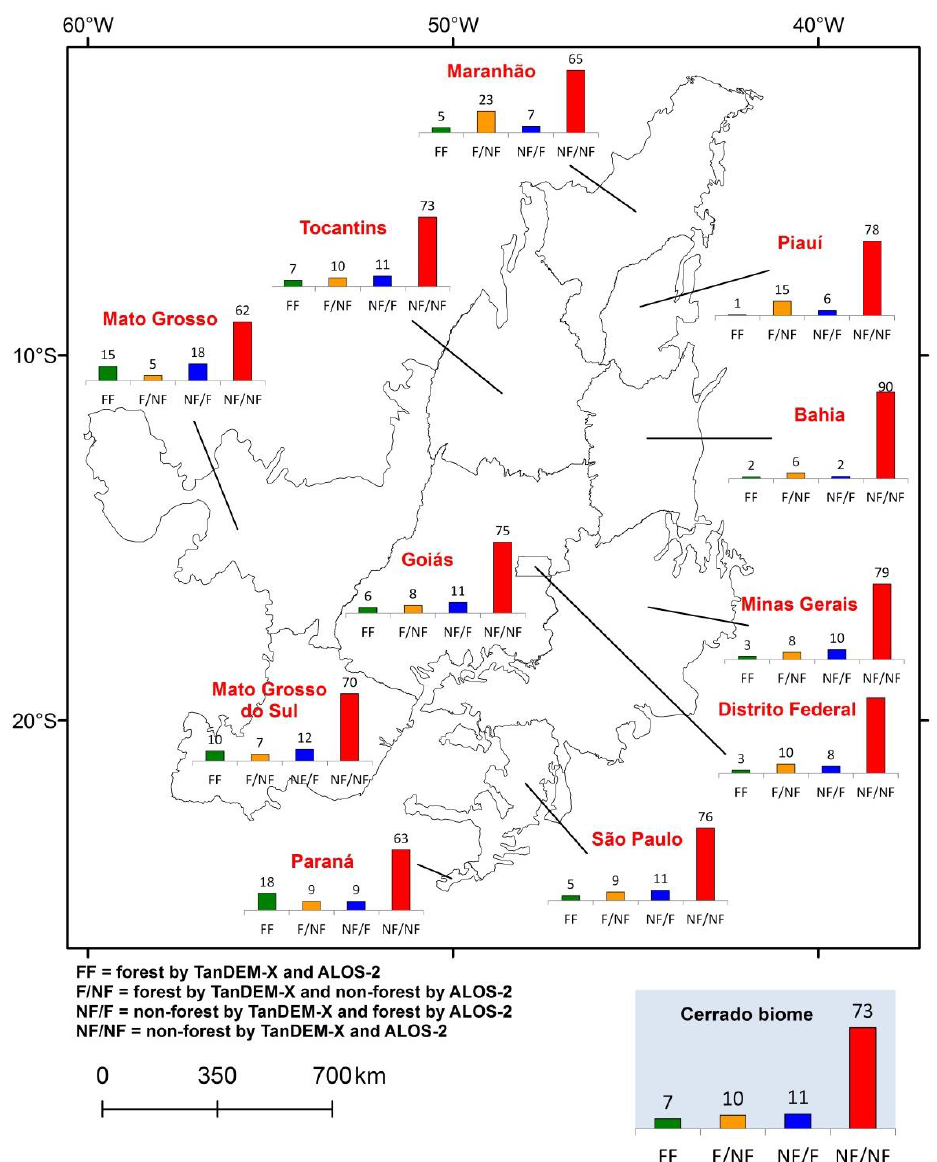
Figure 13. Percentage of pixels classified by the TanDEM-X and ALOS-2 as: forest (FF); non-forest (NF/NF); forest and non-forest (F/NF); and non-forest and forest (NF/F) over the states covered by the Cerrado biome.